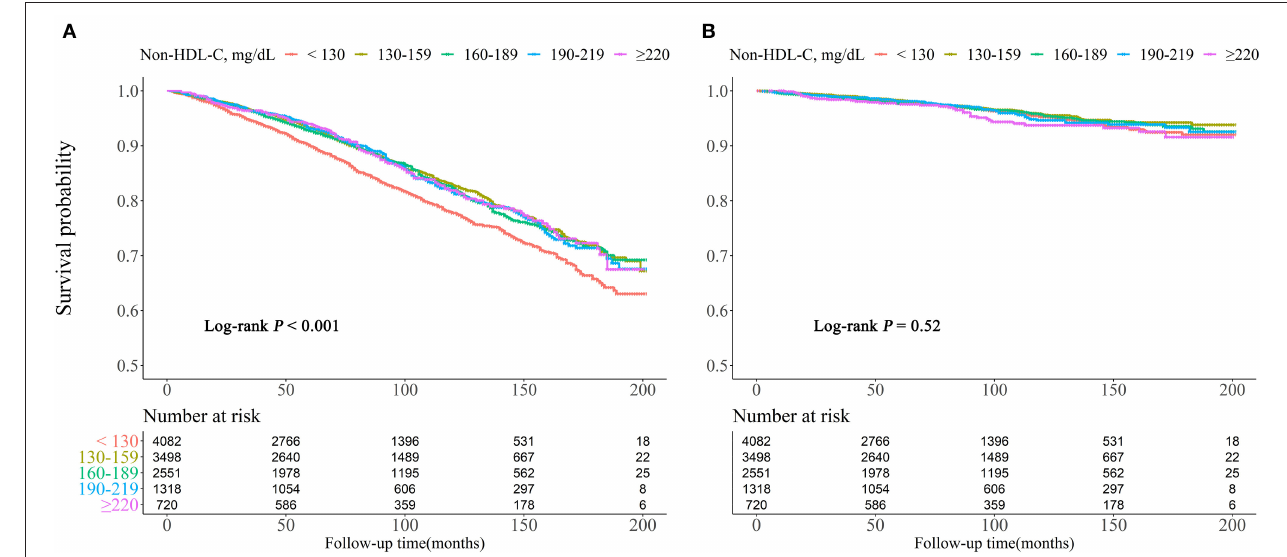
FIGURE 2 | Kaplan–Meier survival curve for all-cause (A) and cardiovascular (B) mortality by non-HDL-C.